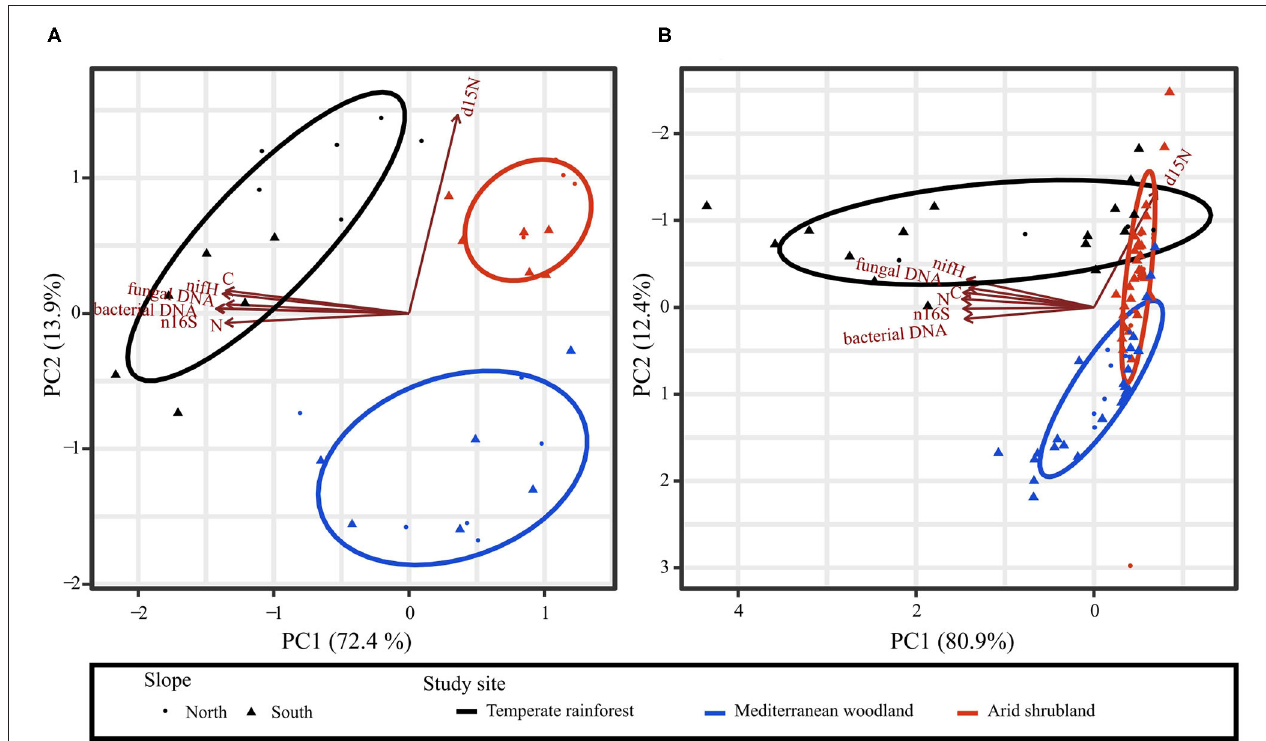
FIGURE 6 | Principal component analyses (PCA) generated from N and C contents, δ 15 N, abundance of bacterial and fungal DNA, and gene copy number of nifH and 16S rRNA genes in (A) bulk topsoil and (B) rhizosphere soil. Name of the respective variable is indicated at each arrowhead. Colors indicate study sites and symbol shapes indicate north- or south-facing slopes. Ellipses show two standard deviations of an assumed two-dimensional normal distribution for each study site. 15 N enrichment with decreasing N content with depth),